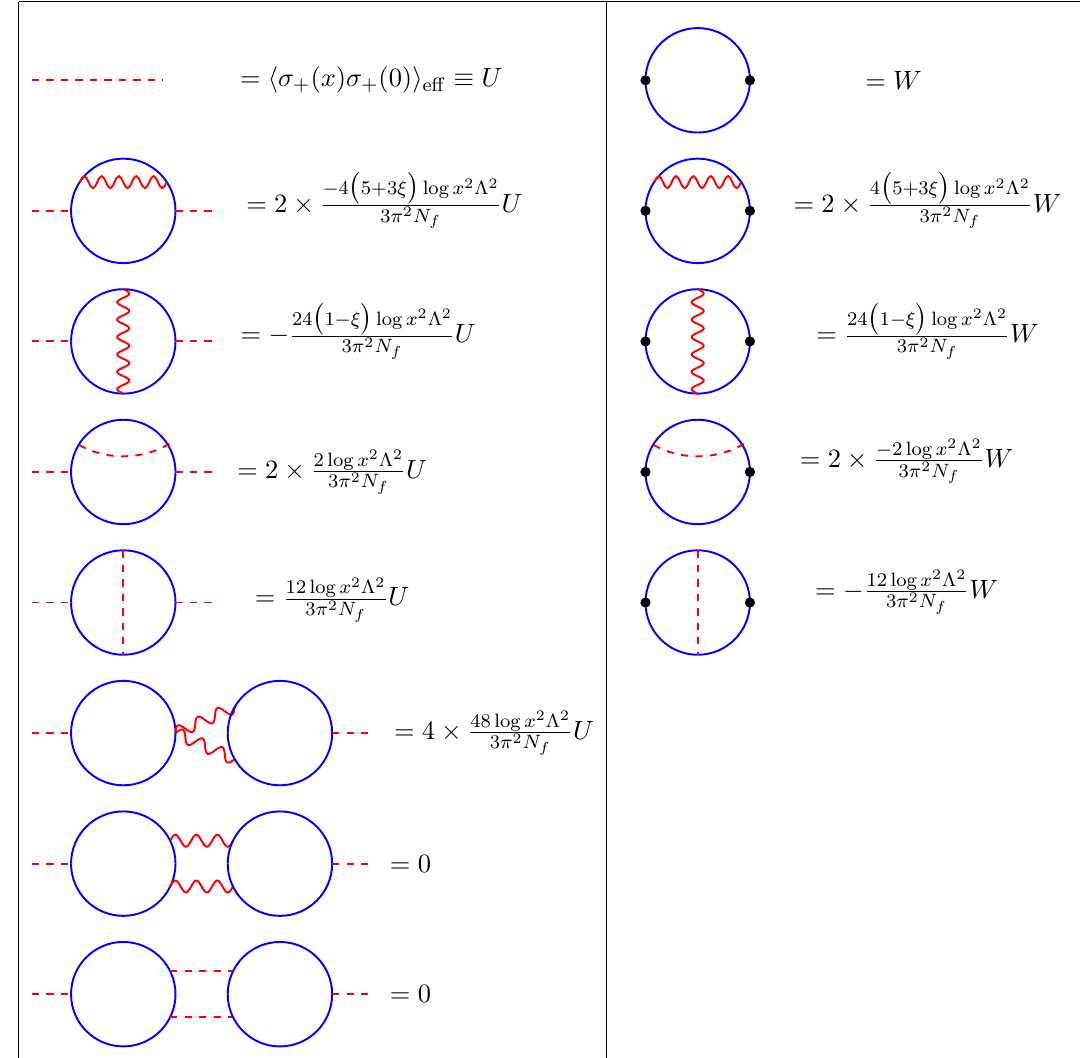
Table 4 . (bQED + ) Results for the individual Feynman graphs appearing in the 2-point correlation functions h (cid:27) + ( x ) (cid:27) + (0) i (left column) 8 and hj (cid:8) j 2 ( x ) j (cid:8) j 2 (0) i (right column). adj adj The photon \sees" all the N (cid:13)avors, (cid:27) and ~ (cid:27) only \see" N = 2 (cid:13)avors. In the Feynman f f graphs, we use red dashed (double dashed) line for (cid:27) (~ (cid:27) ) and blue (double blue) line for (cid:8) (~(cid:8)). The global symmetry of the e(cid:11)ective action (2.28) is